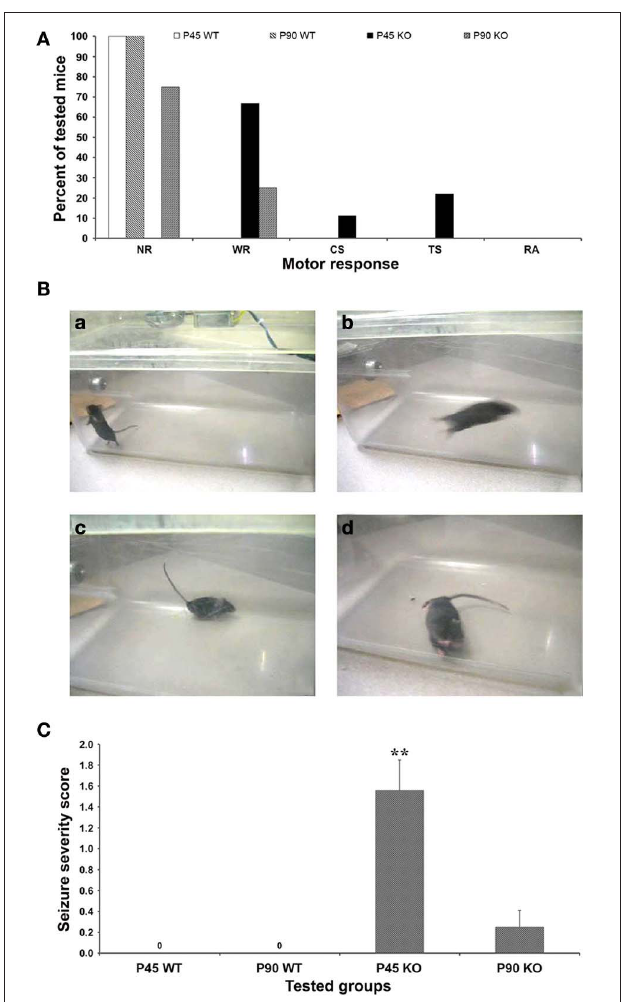
FIGURE 1 | Behavioral response to audiogenic stimuli. (A) Fmr1 KO mice studied at postnatal day (P) 90 showed a less intense motor response to the audiogenic stimuli (6 NR, 2 WR; n = 8) than P45 group (6 WR, 1 CS, 2 TS; n = 9), both higher than WT mice that did not respond behaviorally to the test either at P45 nor at P90. (B) Frames obtained from the video recordings of a P45 WT mouse during exploratory behavior (a), and of P45 Fmr1 KO mice during WR (b), Straub tail (c), TS (d). (C) The seizure severity score (SSS) shows that the intensity of seizing in P45 Fmr1 KO mice is 6-fold higher than in P90 group, both higher than WT mice (no response). ∗∗ P < 0 . 01, Kruskal–Wallis test followed by Dunn’s test. NR, no response; WR, wild running; CS, clonic seizures; TS, tonic seizures; RA, respiratory